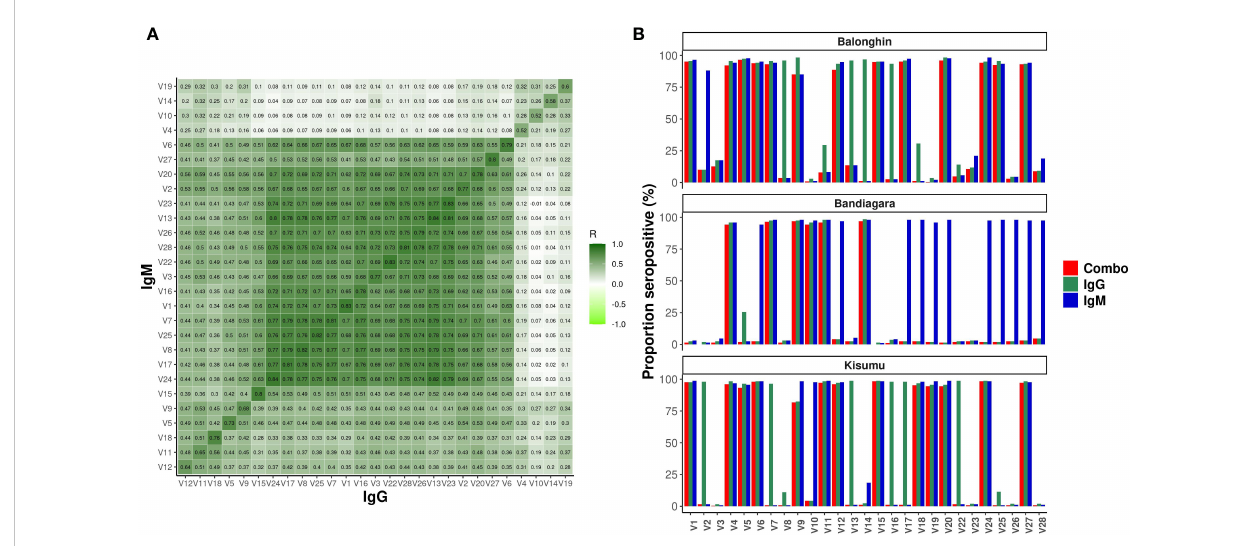
FIGURE 3 Profound diversity of IgG and IgM antibodies to variants of ARMA in Balonghin, Burkina Faso, Bandiagara, Mali and Kisumu, Kenya. (A) Correlation of normalized MFIs for IgG and IgM against 27 variants of ARMA. Pairwise correlation between IgG and IgM reactivities assessed using Spearman ’ s R (B) Seroprevalence ranged between 0.8 - 98.8%, but was comparable between IgG vs. IgM; P = 0.98, Wilcoxon test. The levels of IgM antibodies were higher than IgG, P< 0.001, Wilcoxon test. Combo refers to samples with detectable levels of both IgG and IGM against the same antigen